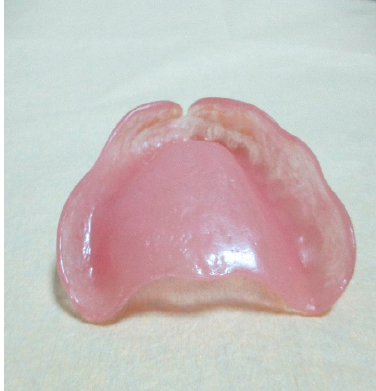
Figure 7. Patient’s denture made from ThermoSens using the conventional laboratory method.